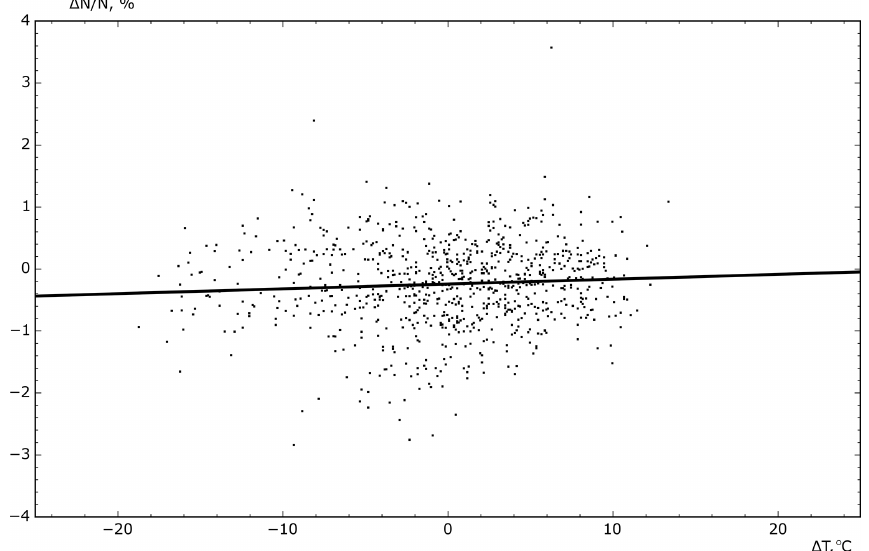
Figure 7. Relationship between (cid:49)N and (cid:49)T (positive temperature effect) for the CARPET-MOSCOW installation determined on the data N 0 of